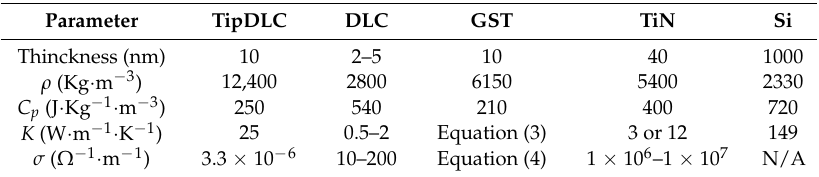
Table 1. Characteristic parameters used in the